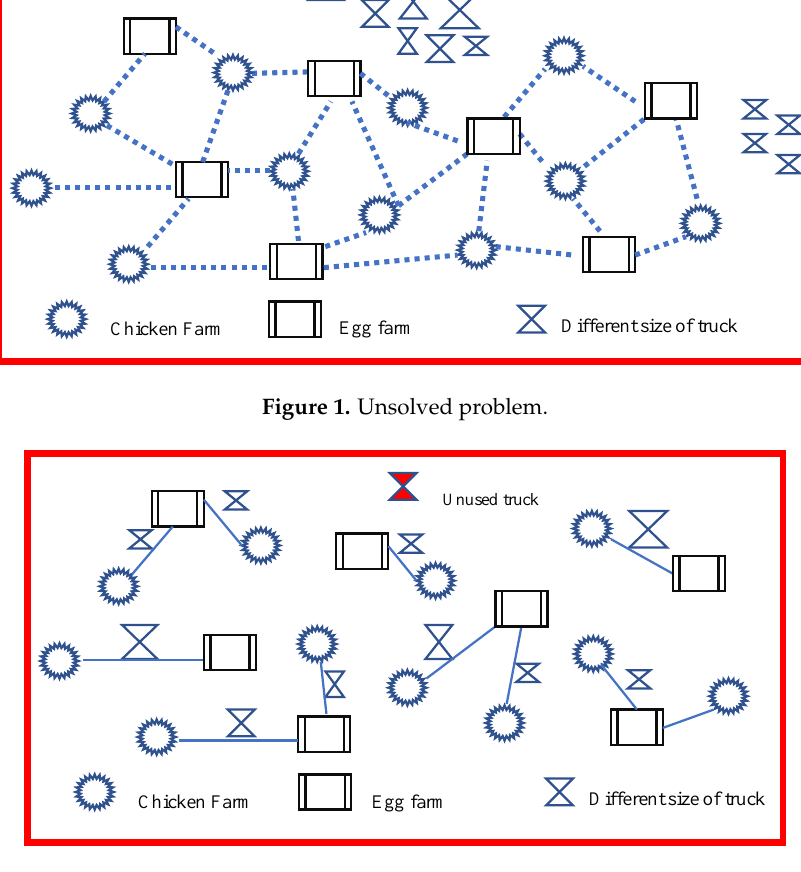
Figure 2. Solved problem.